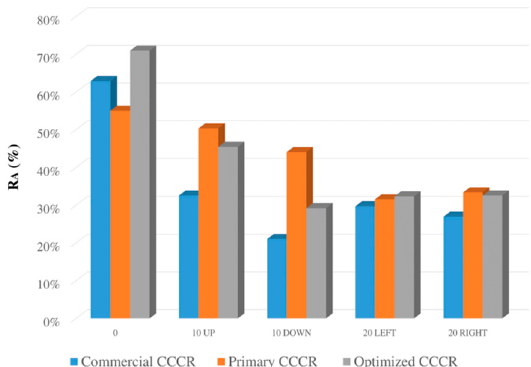
Figure 23. Comparison of reflection coefficient R I of commercial CCCR, primary CCCR, and optimized CCCR.